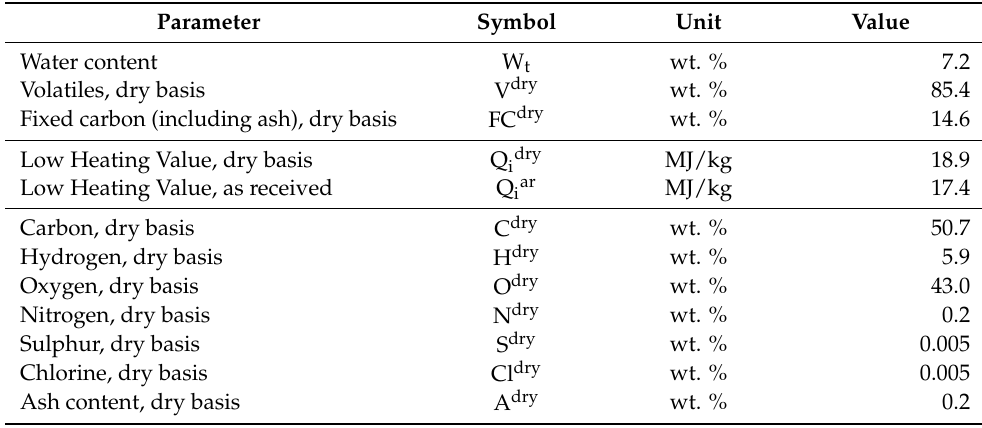
Figure 4. Graphical layout of the two-stage steam gasification model [34] calculation scheme. Table 3. Wood pellets properties